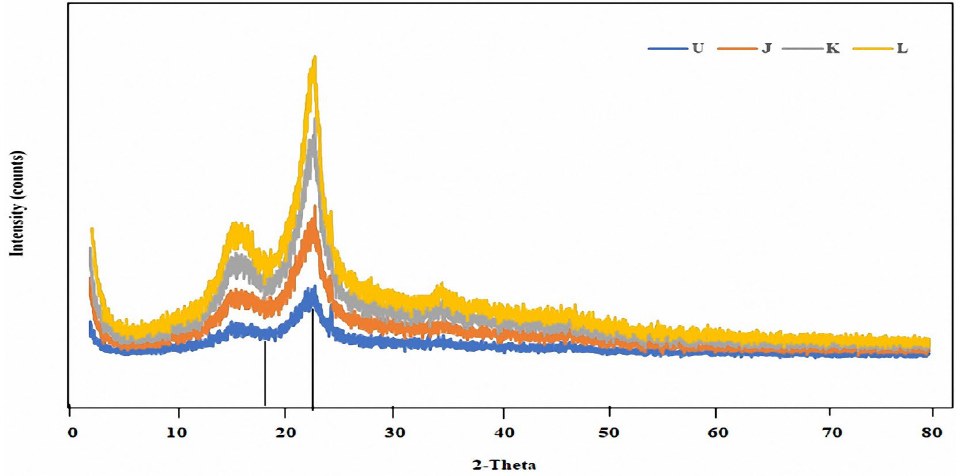
Figure 2. XRD diagram of the untreated and hydrothermally treated rubberwood, ( U ) control, ( J ) 160 °C, pH 8 ( K ) 180 °C, pH 8, and ( L ) 200 °C, pH 8.